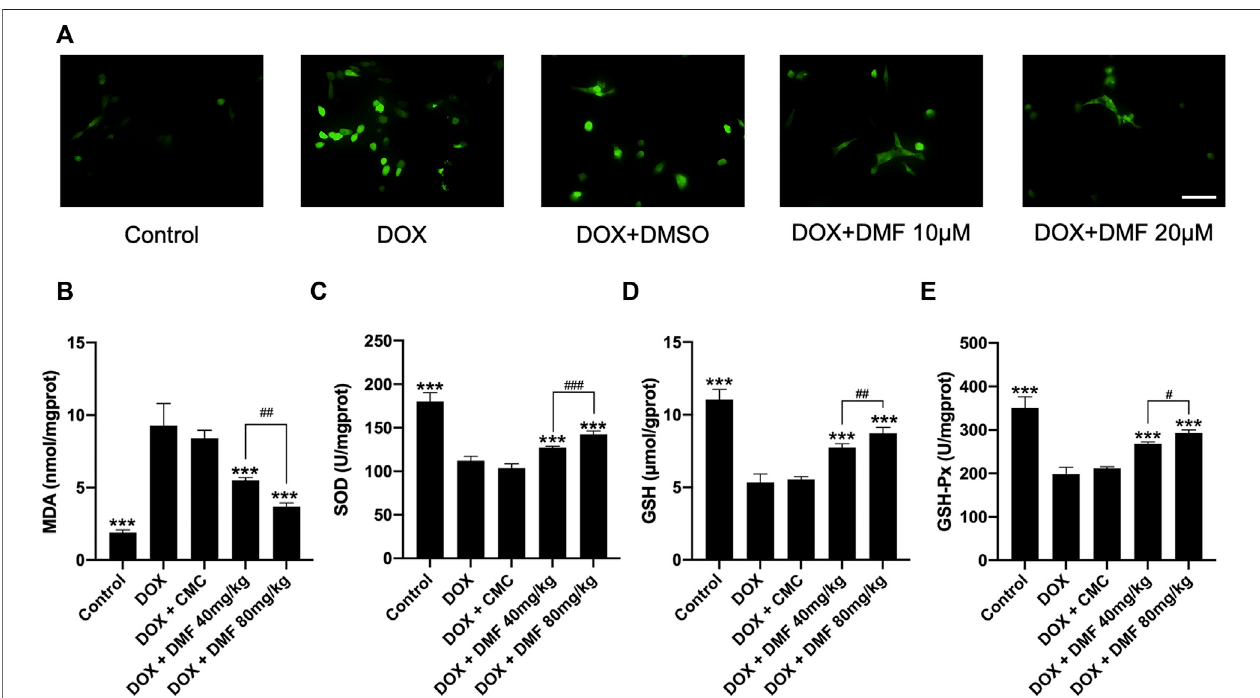
FIGURE 3 | DMF alleviated oxidative stress in vitro and in vivo . (A) Effects of DMF on cellular ROS level in NRCMstreated by DOX ( n = 5, scale bar = 50 μ m). (B – E) Effects ofDMF on the levels of MDA, SOD, GSH, and GSH-Px in hearts after DOX treatment ( n = 6). Data are presented as the mean ± SD. *** p < 0.001, compared